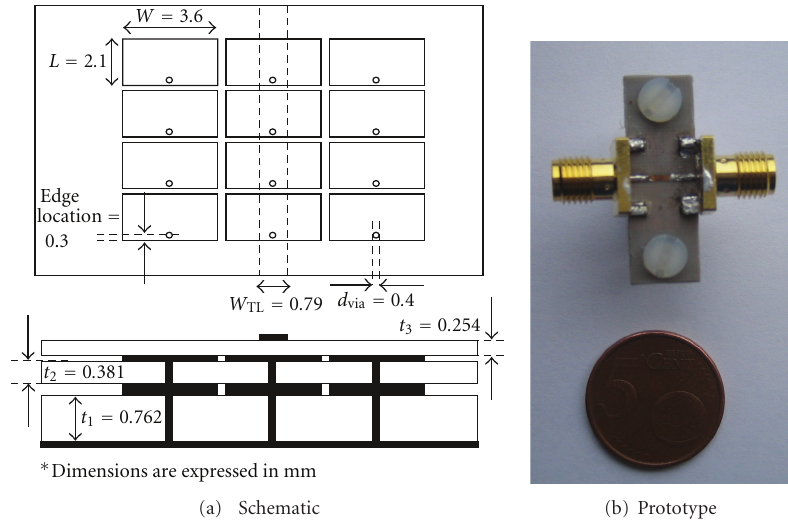
Figure 9: Multilayered mushroom with rectangular shape, 4 elements and edge-located via (F-shape).